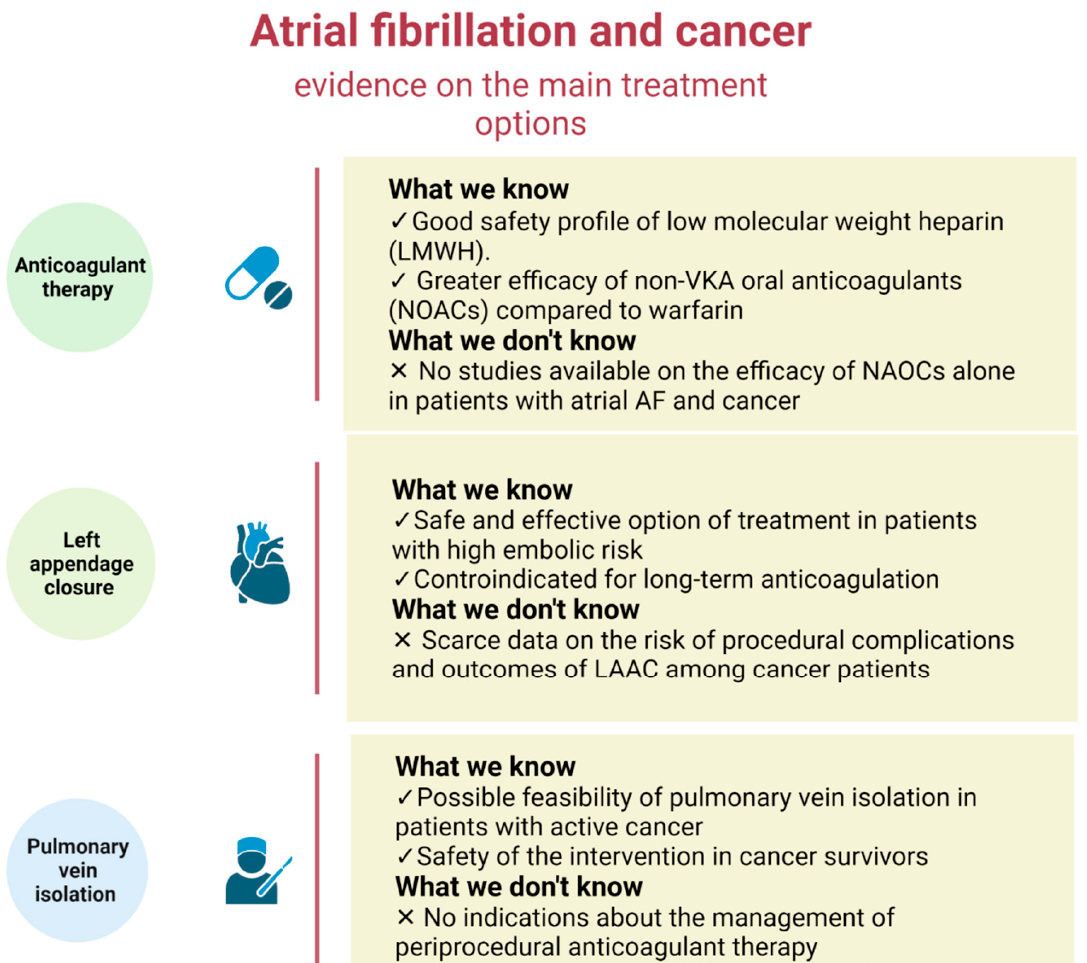
Figure 1. Overview of possible therapeutic strategies for atrial fibrillation in cancer patients. The main therapeutic strategies used to treat atrial fibrillation have only been partially explored in the cancer patient. Although a number of studies have advanced our knowledge of how to manage the oncological patient with atrial fibrillation, there are still a fair number of questions that have not yet been fully answered. Created with Biorender.com (accessed on 13 July 2022).